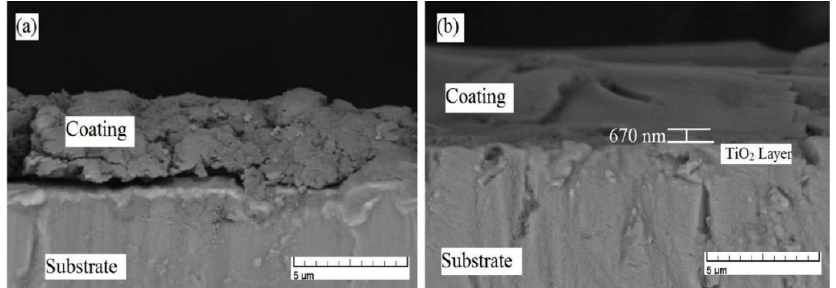
Figure 5. Cross-sectional SEM images of ( a ) HAp and ( b ) FGC HAp-TiO 2 coatings [33], reprinted with permission from Elsevier.